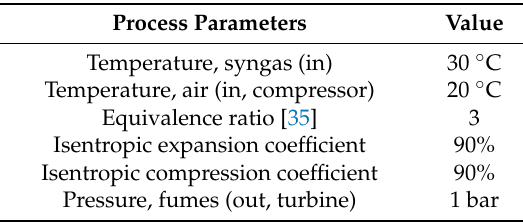
Table 7. Gas turbine’s cycle operating